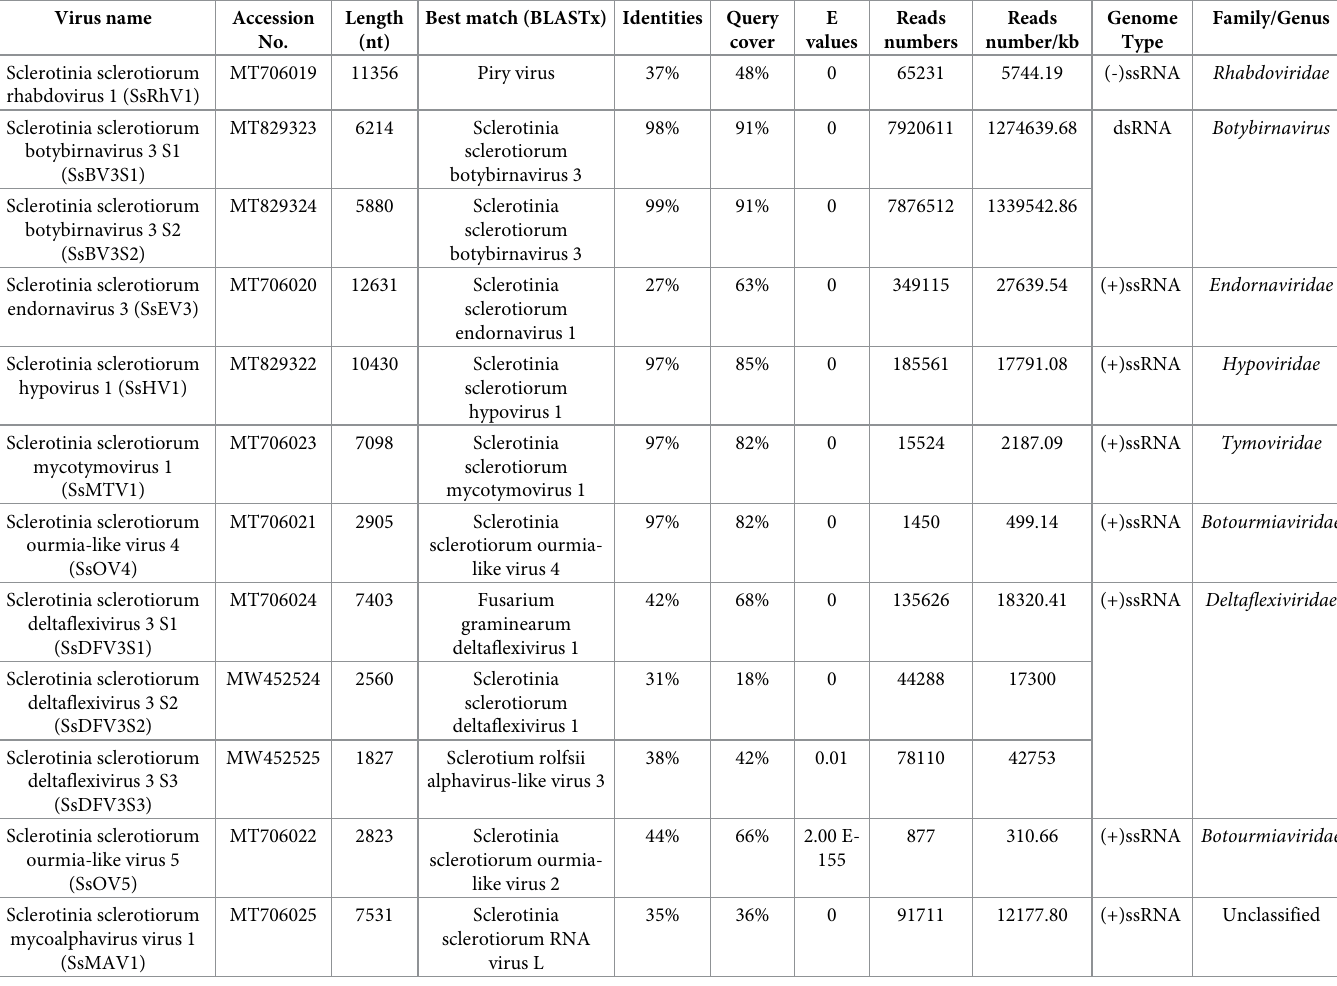
Table 1. The information of the nine viruses in strain SX276. Virus